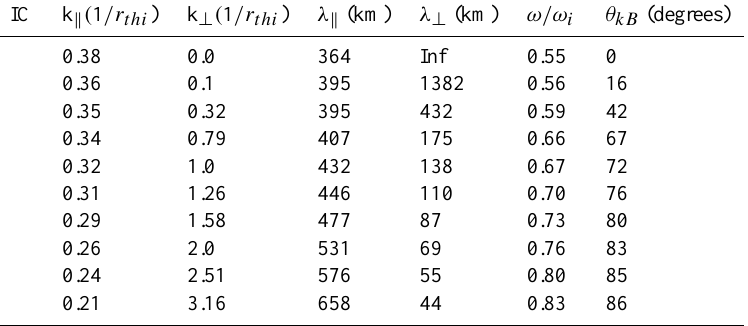
Fig. 11. Solutions from WHAMP code. (a) shows the real part and (b) shows the imaginary part of frequency of the ion cyclotron wave with k ⊥ =0 (blue solution continuing to highest k k ), k ⊥ =0.32 (green), k ⊥ =0.79 (orange), k ⊥ =1.0 (aqua), k ⊥ =1.26 (magenta), k ⊥ =1.58 (yellow), k ⊥ =2.0 (gray), k ⊥ =2.51 (blue), k ⊥ =3.16 (green) normalized to ion cyclotron frequency at B =85nT as a function of k k . Table 4. Properties of Ion Cyclotron waves (IC) when damping becomes 20% of the real frequency (calculated from WHAMP model with Maxwellian electron and proton species). Columns list parallel and perpendicular wave numbers and wave lengths, real frequency and wave propagation angle with respect to magnetic field. Ion cyclotron radius, r thi , used here is 22km. IC k k ( 1 /r thi ) k ⊥ ( 1 /r thi ) λ k